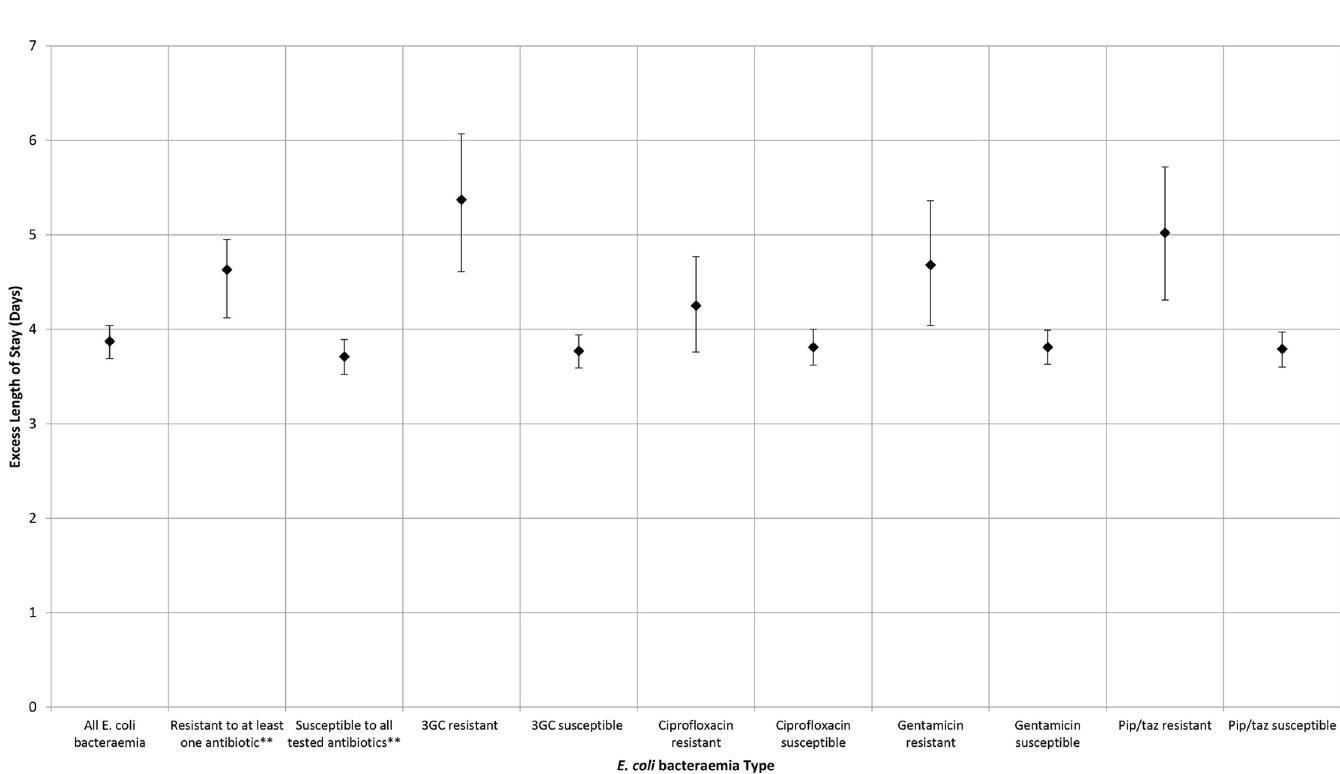
Fig 3. Excess length of Stay of E . coli Bacteraemia. Excess days associated with an exposure were calculated in comparison to “non-infected” non-exposed, i.e. patients in hospital without an E . coli bacteraemia. Error bars represent the 95% confidence intervals derived from bootstrapping. �� “Resistant to 1 or more” refers to being resistant to at least one of the tested antibiotics (ciprofloxacin, third generation cephalosporins, gentamicin, piperacillin/tazobactam and carbapenems). Abbreviations: 3GC; third-generation cephalosporin, E . coli; Escherichia coli , pip/taz; piperacillin/tazobactam.